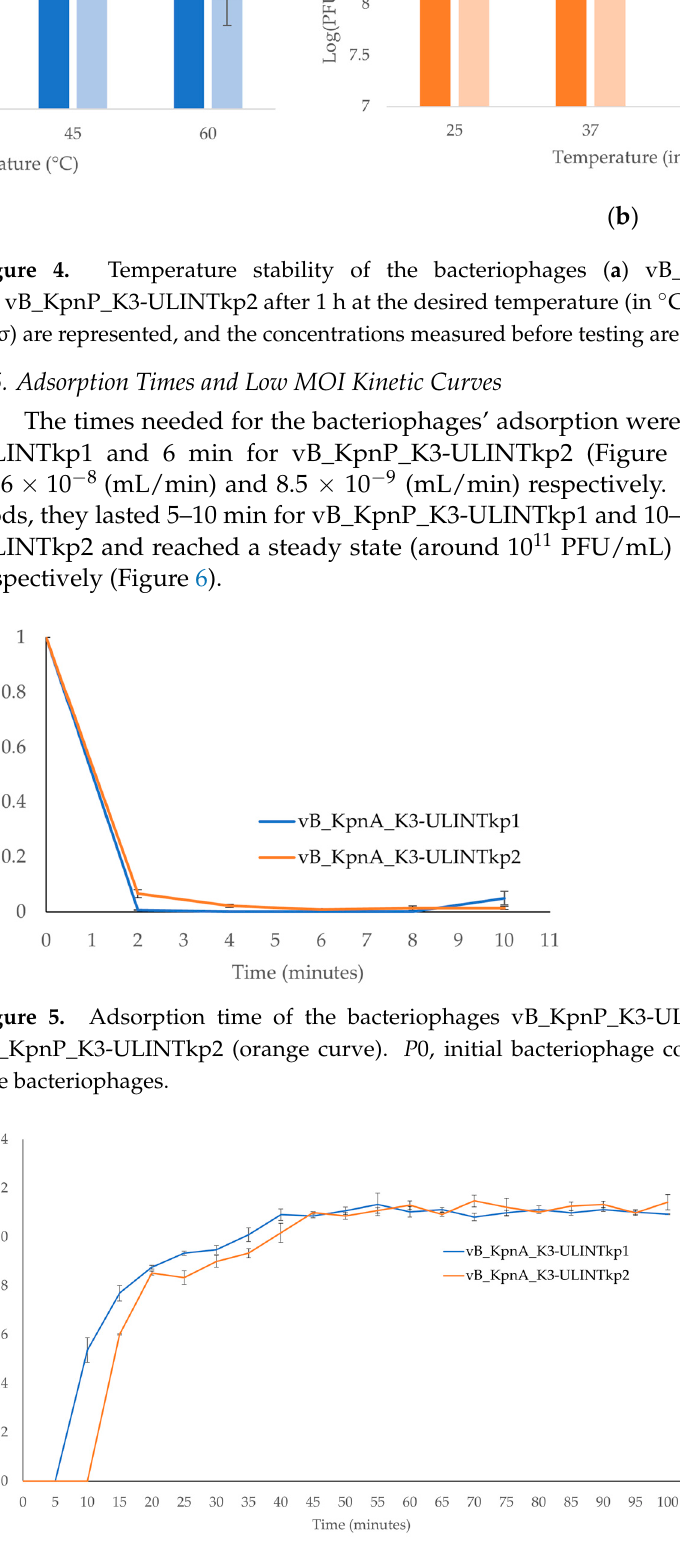
Figure 4. Temperature stability of the bacteriophages ( a ) vB_KpnP_K3-ULINTkp1 and ( b ) vB_KpnP_K3-ULINTkp2 after 1 h at the desired temperature (in °C). The means of 3 titrations (± σ ) are represented, and the concentrations measured before testing are represented with dark bars.